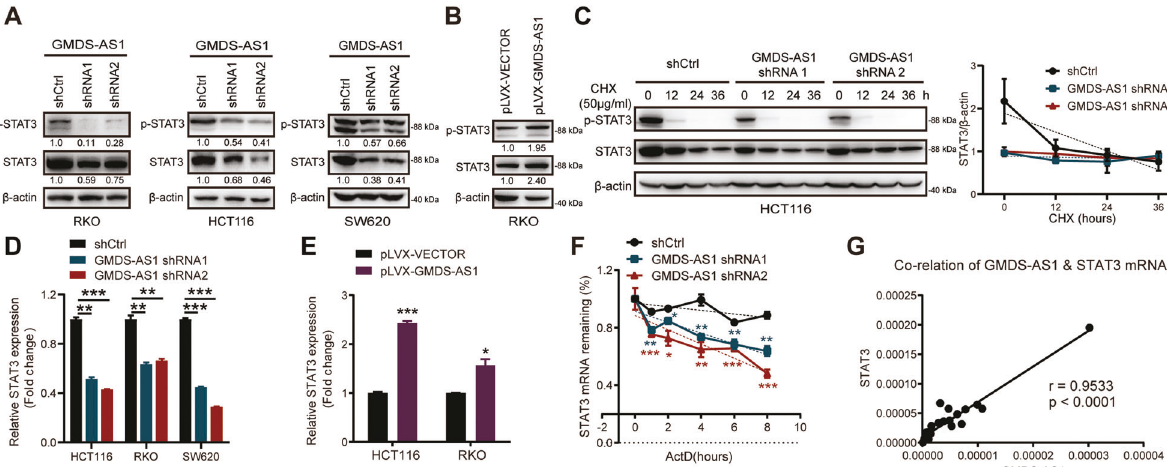
Fig. 4 GMDS-AS1 increases STAT3 protein expression by stabilizing STAT3 mRNA. A , B The protein expression levels of p-STAT3 (Y705) and total STAT3 in RKO cells ( A , left), HCT116 cells ( A , middle) and SW620 cells ( A , right) stably transduced with control or GMDS-AS1 shRNA were detected by immunoblotting. The same approach was used to measure p-STAT3 (Y705) and total STAT3 protein levels in RKO cells ( B ) stably expressing the control or GMDS-AS1 plasmid. C HCT116 cells stably transduced with control or GMDS-AS1 shRNA were treated with CHX (50 μ g/ml) for the indicated times, and the protein expression levels of p-STAT3 (Y705) and total STAT3 were detected by immunoblotting (left). Densitometric analysis curve of total STAT3 protein levels (right). A – C β -actin was the endogenous control. D , E Relative mRNA expression levels of STAT3 in GMDS-AS1 control/KD HCT116, SW620 and RKO cells were measured by qPCR ( D ). STAT3 mRNA expression levels were detected in control and stable GMDS-AS1-expressing HCT116 and RKO cells ( E ). 18S was the endogenous control. F Relative mRNA expression levels of STAT3 in HCT116 cells stably transduced with control or GMDS-AS1 shRNA after actinomycin D (ActD) (10 μ M) treatment for the indicated times were measured by qPCR. G Correlation of GMDS-AS1 and STAT3 mRNA expression levels in 23 CRC tissues as detected by qPCR. Pearson ’ s correlation analysis was performed to calculate the R and p values. D – F Values are expressed as the means ± SEM, n = 3. *** p < 0.001, ** p < 0.01, and * p < 0.05 by two-tailed Student ’ s t